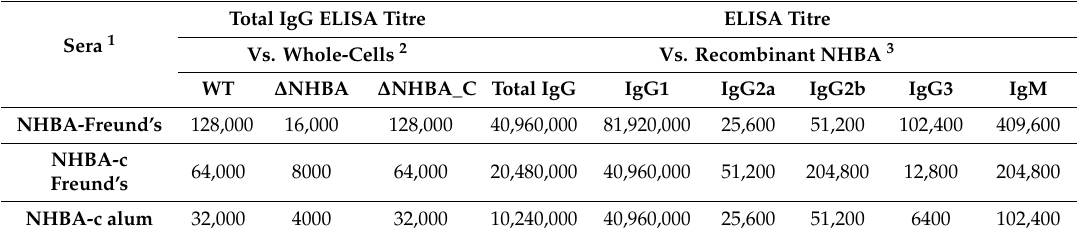
Table 1. Antigenicity of gonococcal NHBA and NHBA-c.